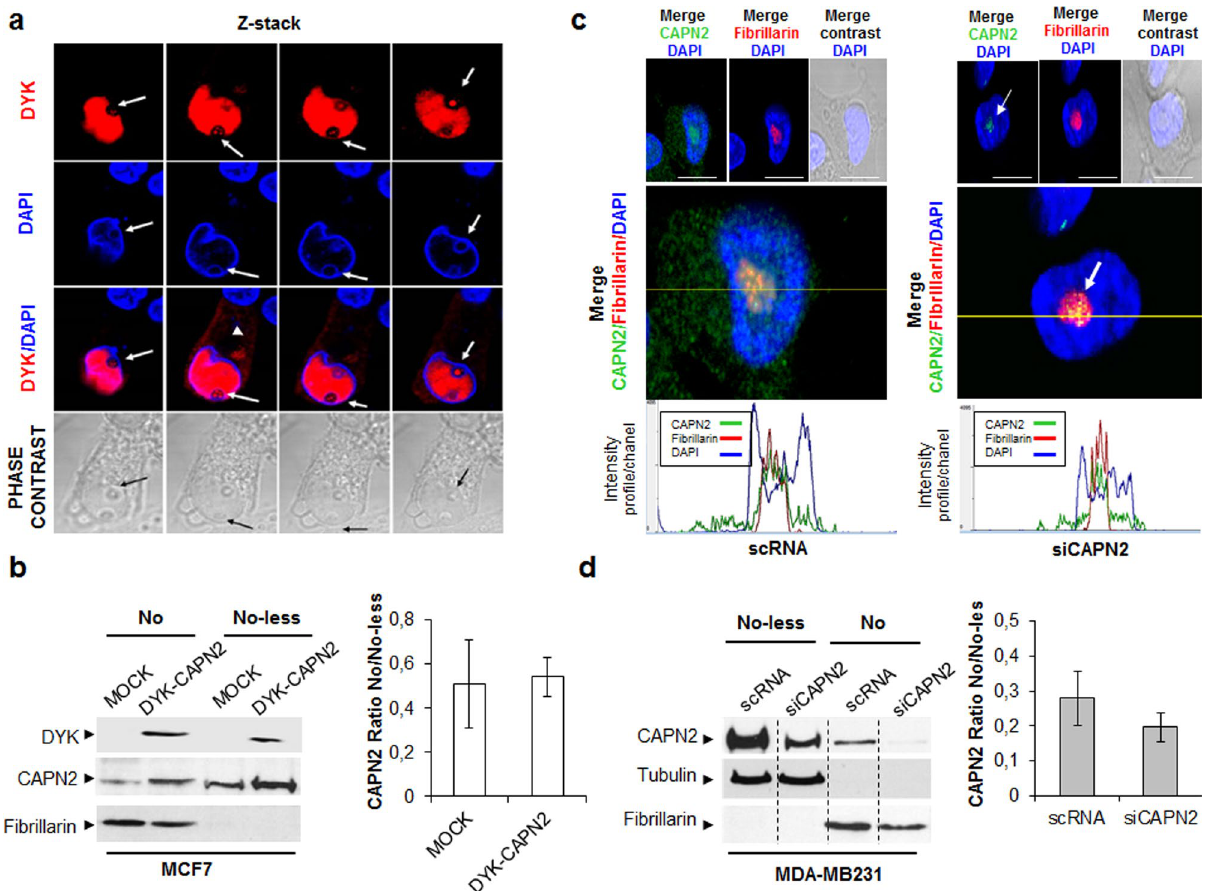
Figure 2. Specificity and expression-dependent localization of CAPN2 in nucleoli of BCCs. ( a ) Subnuclear distribution of ectopically expressed DYK-CAPN2 in MCF-7 cells analyzed by fluorescence staining with anti- DYK antibody (red) or DAPI (blue). Z-stack images (left to right) are shown. DYK-CAPN2 detected in nucleoli (arrow) and cytosol (arrowhead) is pointed out. Scale bars 20 μm. ( b ) Subnuclear distribution of DYK-CAPN2 analyzed by western blot in nucleolar (No) and nucleolar-less (No-less) fractions of MCF-7 cells transfected with either MSCV (Mock) or DYK-CAPN2 expression vector. Nucleolar CAPN2 was analyzed with both, anti-DYK and anti-CAPN2 antibodies. Fibrillarin was used to assess the purity of No fractions. The ratio of No/No-less CAPN2 is represented as mean ± SEM. No significant differences were found among both groups (n = 3). ( c ) Immunofluorescence analysis of CAPN2 in scRNA/siCAPN2 MDA-MB-231 transfected cells. Merge images of DAPI (blue) and either, CAPN2 (green), fibrillarin (red) or phase contrast are shown. Scale bars 20 μm. Representative images of all cells are shown. Magnification and H intensity profiles/channel exhibit the presence of residual CAPN2 (arrow) in nucleoli of CAPN2-silenced cells. ( d ) Subnuclear distribution of CAPN2 analyzed by western blot in No and No-less fractions of MDA-MB-231 cells transfected either with, scRNA or siCAPN2. Fibrillarin (No) and tubulin (No-less) were used to assess the purity of fractions. Data were quantified and plotted as mean CAPN2 No/No-less ratio ± SEM. No significant differences were found (n = 6). Juxtaposed images from different lanes in the same blot are separated by dotted lines in ( d ). Full-length blots are shown in Supplementary Fig.